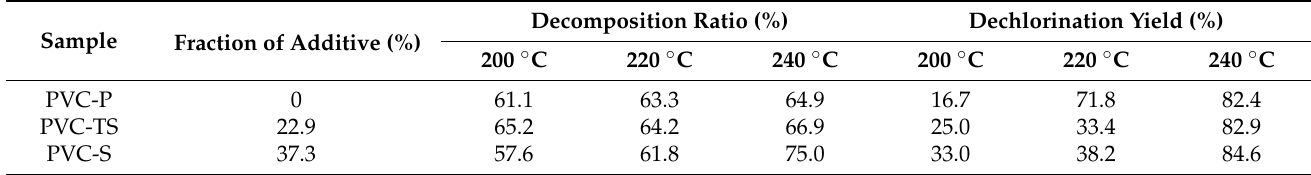
Table 3. Decomposition ratio and dechlorination yield of various PVC